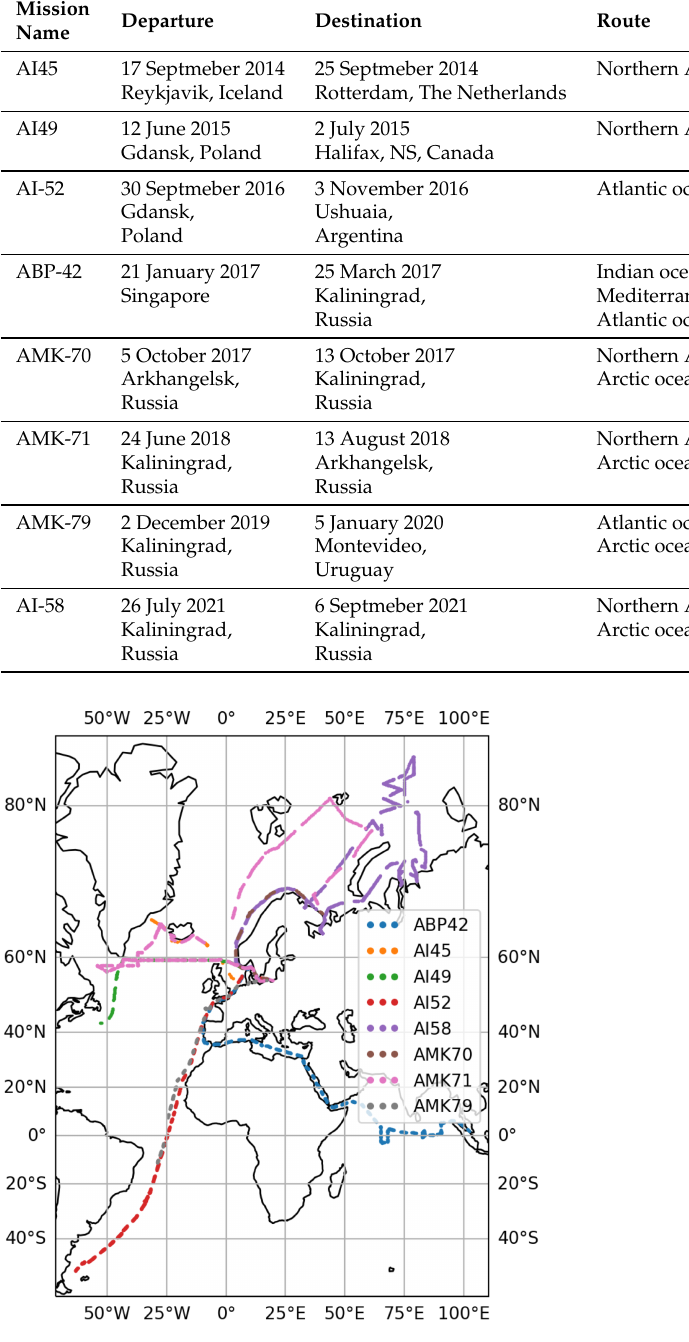
Figure 3. The map of marine missions contributing to the subset of the DASIO collection used in this study. The points represent the positions of a ship each hour during the corresponding expedition. The tracks are discontinuous due to the sampling strategy of our study: the images were not taken during the nighttime (when the sun’s altitude is lower than 5 ◦